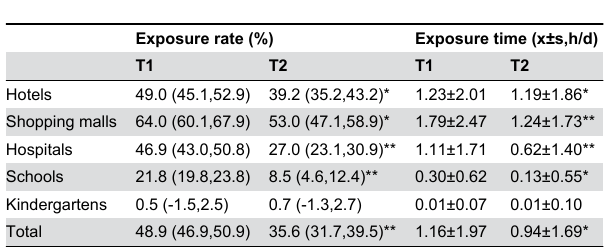
Table 4. Daily exposure to secondhand smoke in the workplace before and after legislation.